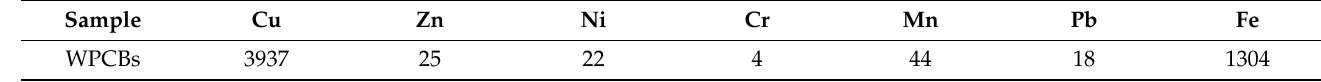
Table 3. Heavy metal contents by AAS analysis in